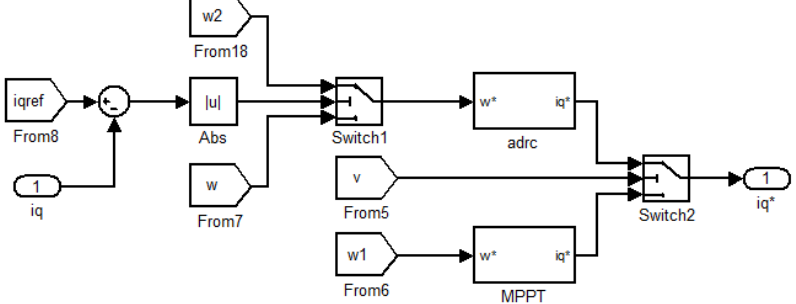
Figure 15. The switching Simulink model.